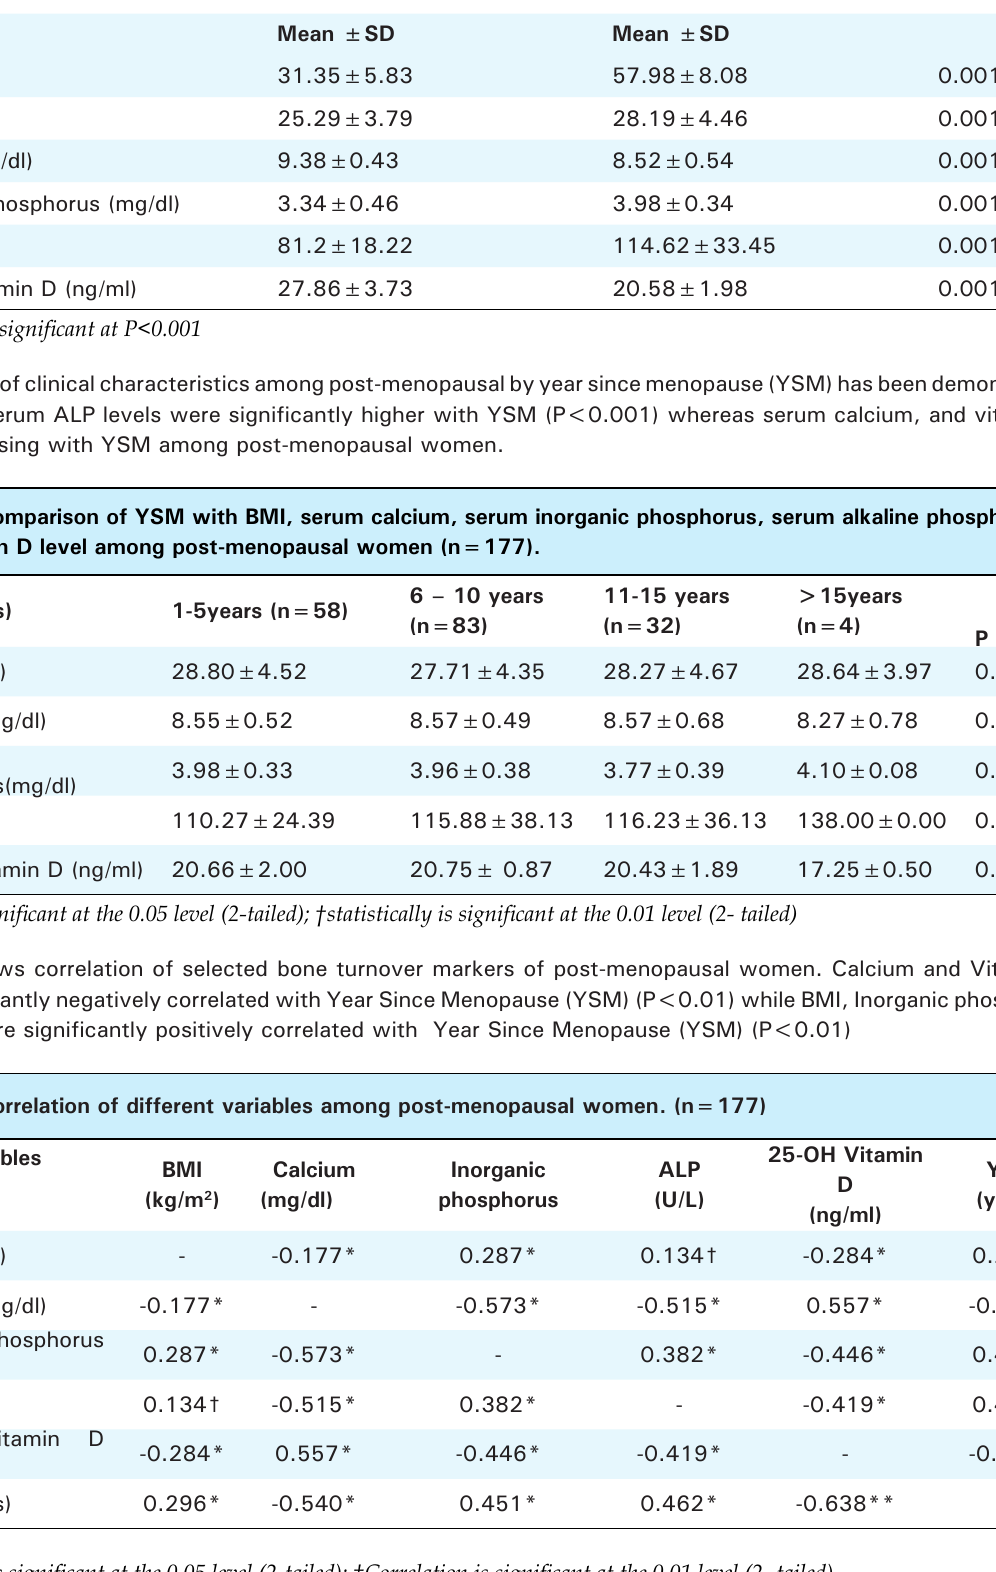
Table 1. Clinical characteristics of the Pre-menopausal and Post-menopausal women (n=354). Variables